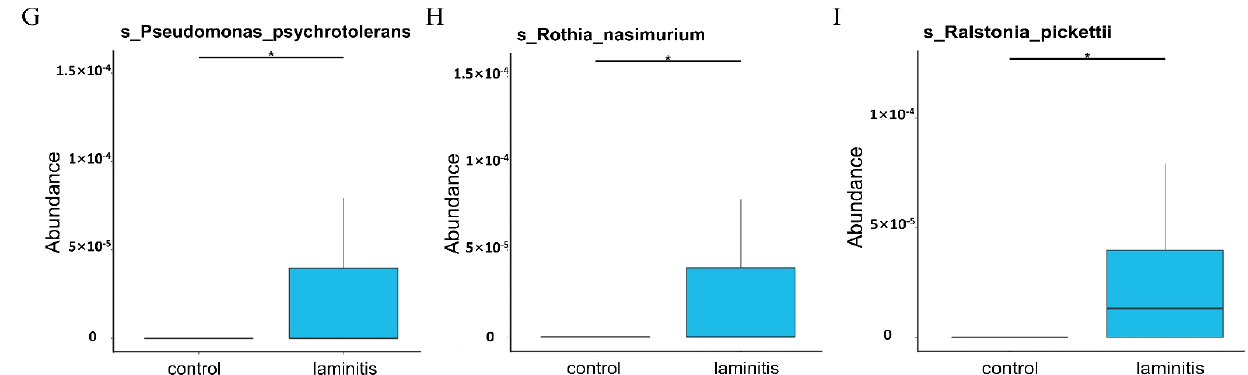
Figure 5. MetaStat analysis The relative abundance of ( A ) Acetobacter pasteurianus , ( B ) Clostridium papyrosolves , ( C ) Ruminococcaceae bacterium AE2021 , ( D ) Porphyromonas crevioricanis , ( E ) Pseudomonas boreopolis , ( F ) Alysiella_crassa , ( G ) Pseudomonas psychrotolerans , ( H ) Rothia nasimurium , and ( I ) Ralstonia pickettii . * p < 0.05 is significantly different from laminitis group.